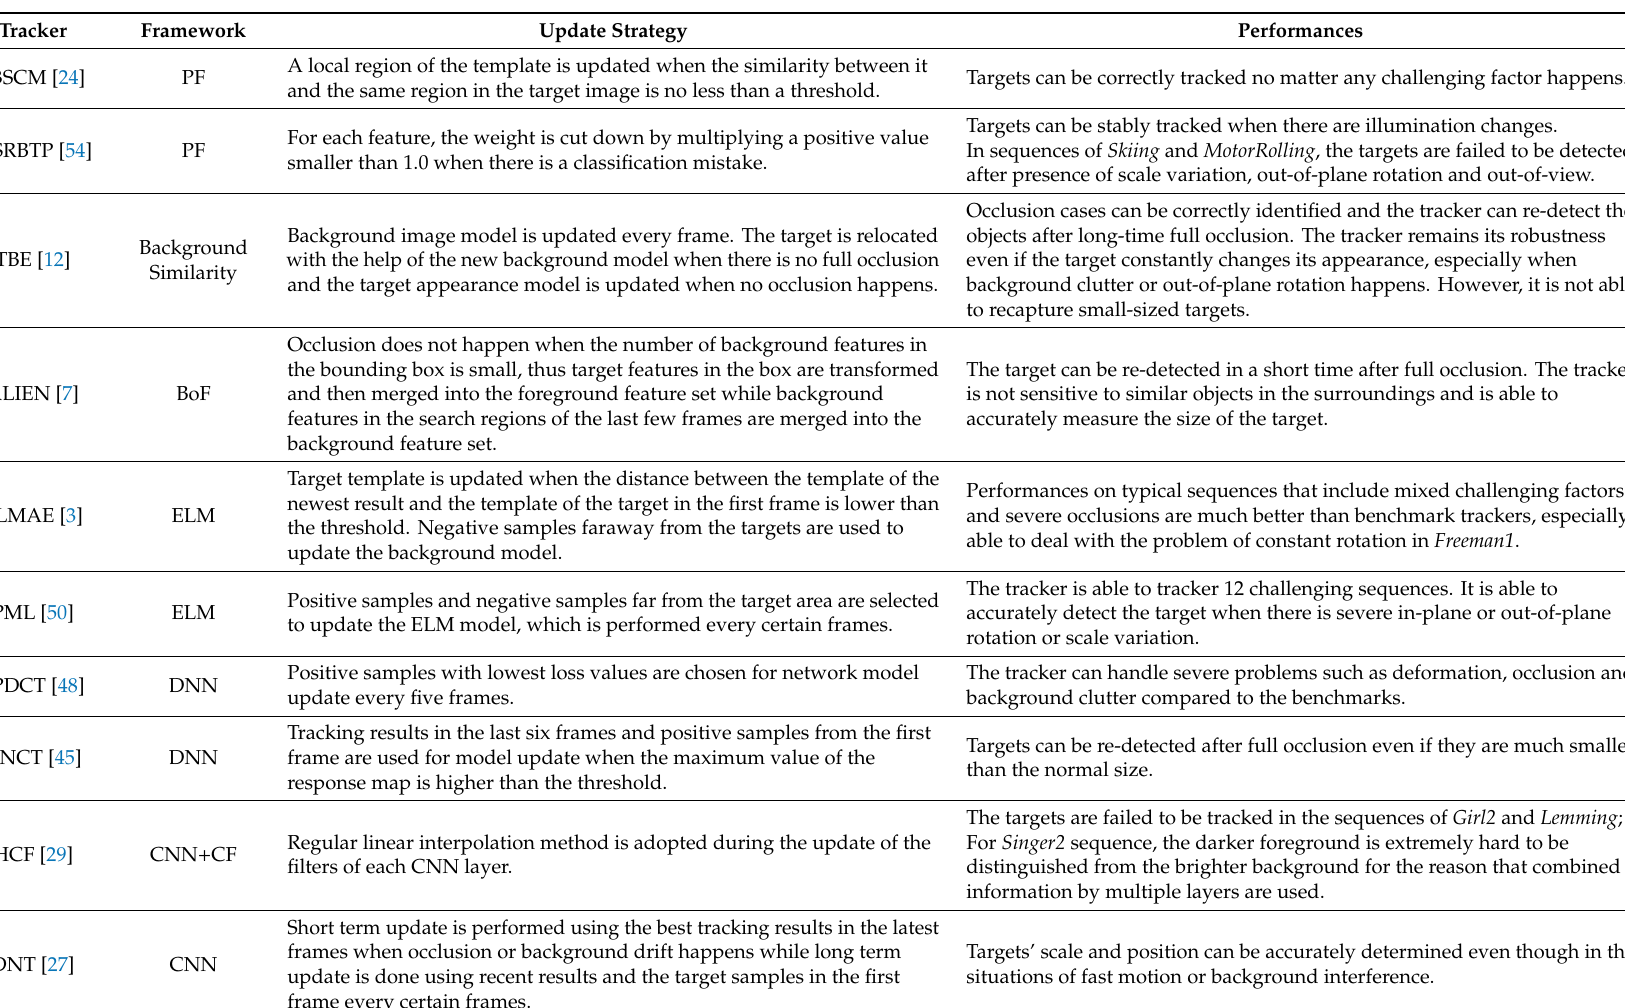
Table 1. Model update strategies in recent years and their merits and